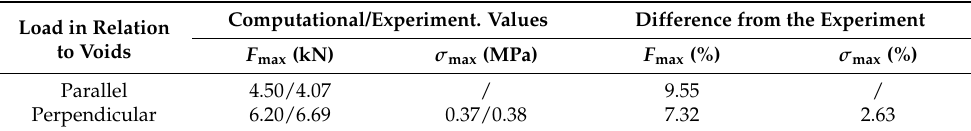
Table 7. Comparison of calibrated computational and experimental models.